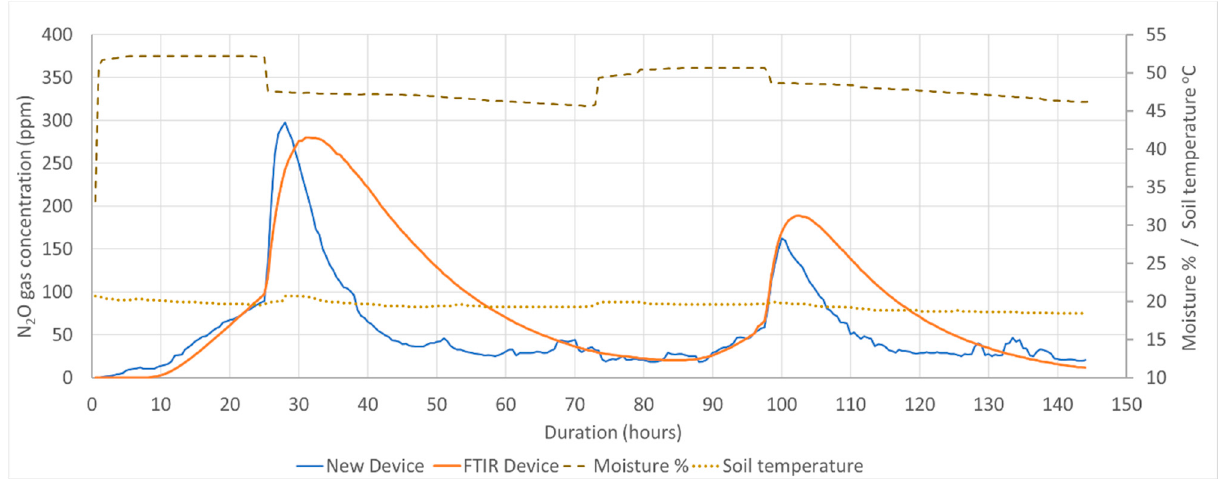
Figure 11. Recorded N 2 O gas concentrations by the new and reference devices.